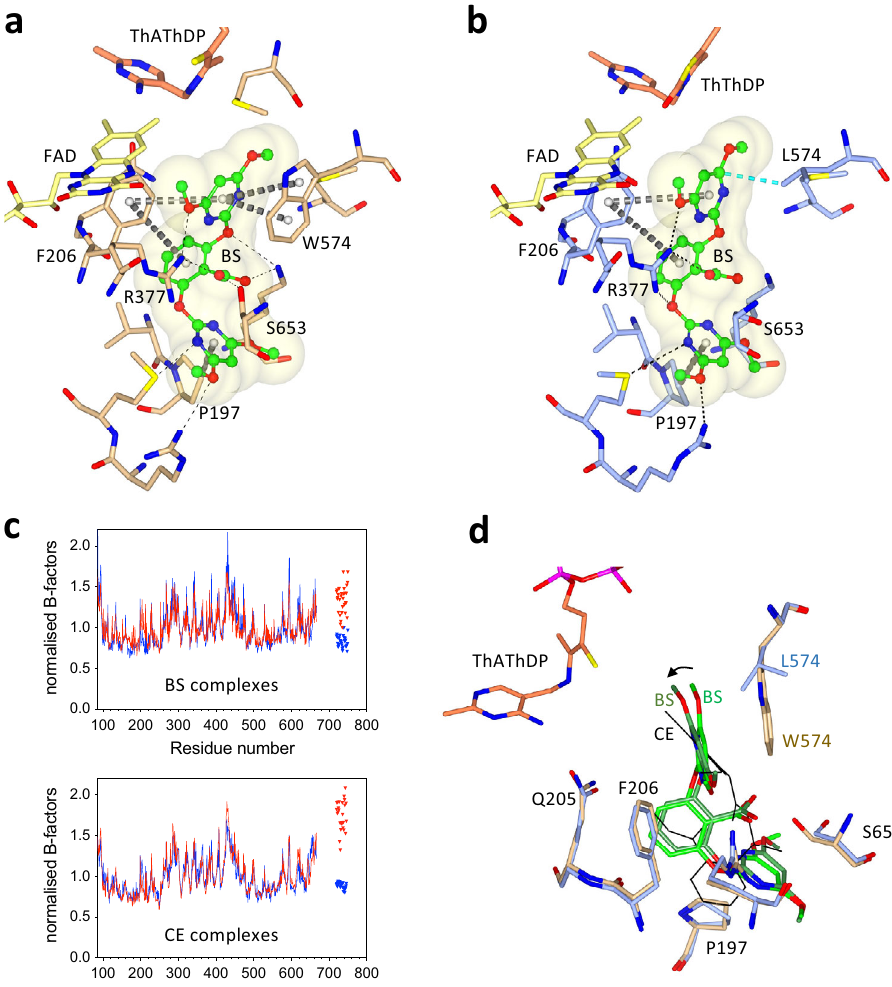
Fig. 5 The binding mode of BS in WT and in the W574L At AHAS mutant. a The interactions of BS with WT At AHAS (PDB code: 1YBH 38 ). ThDP is degraded to ThAThDP (light brown). b The interactions of BS with the W574L mutant. ThDP is oxidized to ThThDP (light brown). a , b BS is in green and ball and stick representation. The FAD is in yellow and in stick representation. Dashed lines represent hydrogen bonds (black). Grey dashed cylinders represent π – π interactions. Blue dashed cylinders represent hydrophobic interactions. c B-factor plot for the polypeptide and herbicide. An increase in normalized B-factor for the herbicide indicates it is not bound as tightly to the mutant as it is to the WT enzyme (top panel). However, the destabilization is not as profound compared (lower panel) to the normalized B-factors for the two CE structures (i.e., WT and W574L mutants). Blue and red represent WT and mutant enzymes, respectively. Lines and triangles represent polypeptide and inhibitor, respectively. d Superimposition of the WT At AHAS-BS, W574L- BS, and W574L-CE complexes. The superimposition of the WT At AHAS-BS and W574L-BS structures shows the rotation of the heterocyclic ring that occurs when W574 is mutated to leucine. The superimposition with W574L-CE (CE represented by thin black sticks) shows that the movement of the heterocyclic ring in the W574L mutant is greater for CE than